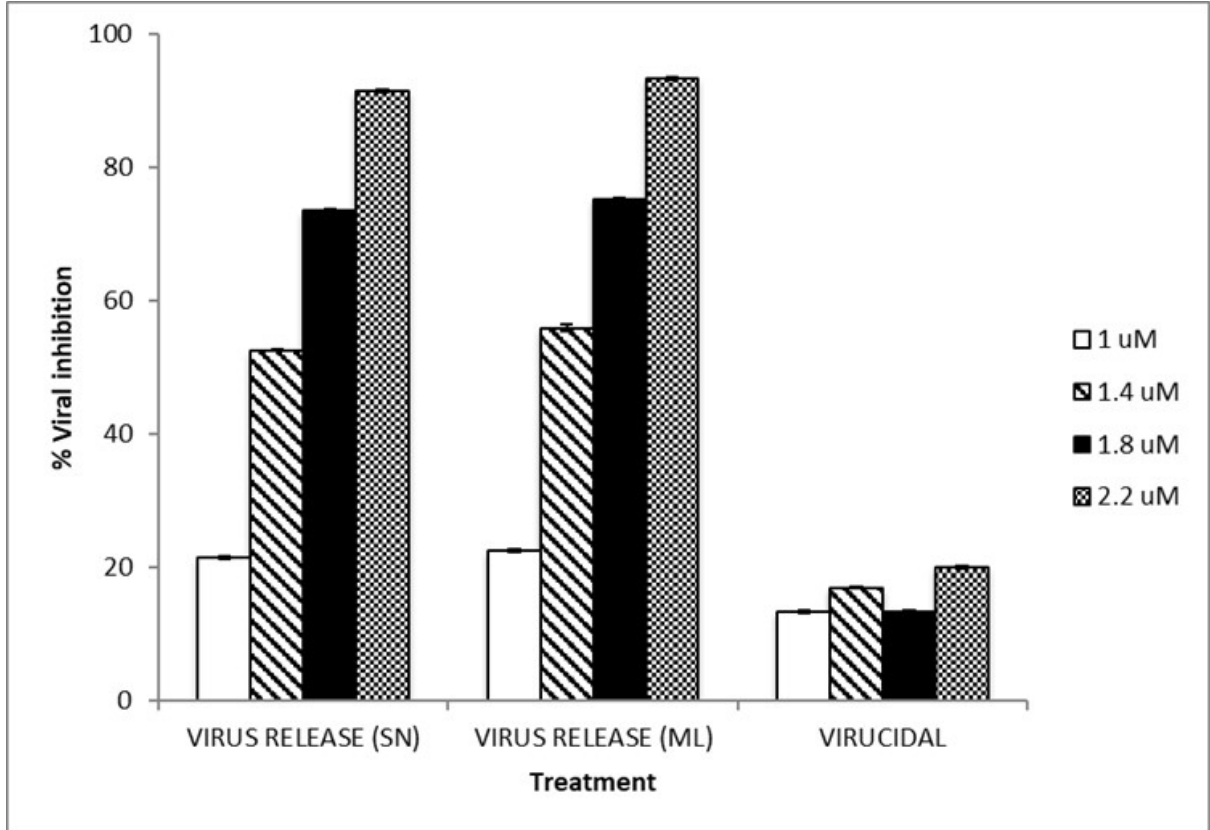
Figure 2. DENV-2 stock was treated with different concentrations of TIZ for 1 h at 37 °C for subsequent titration by plaque assay for virucidal test and viral release assays. The experiment shows the mean of three determinations of viral inhibition + SD in plaque assay: virus released in supernatant (SN), virus released from cell monolayer (ML), and virucidal activity.